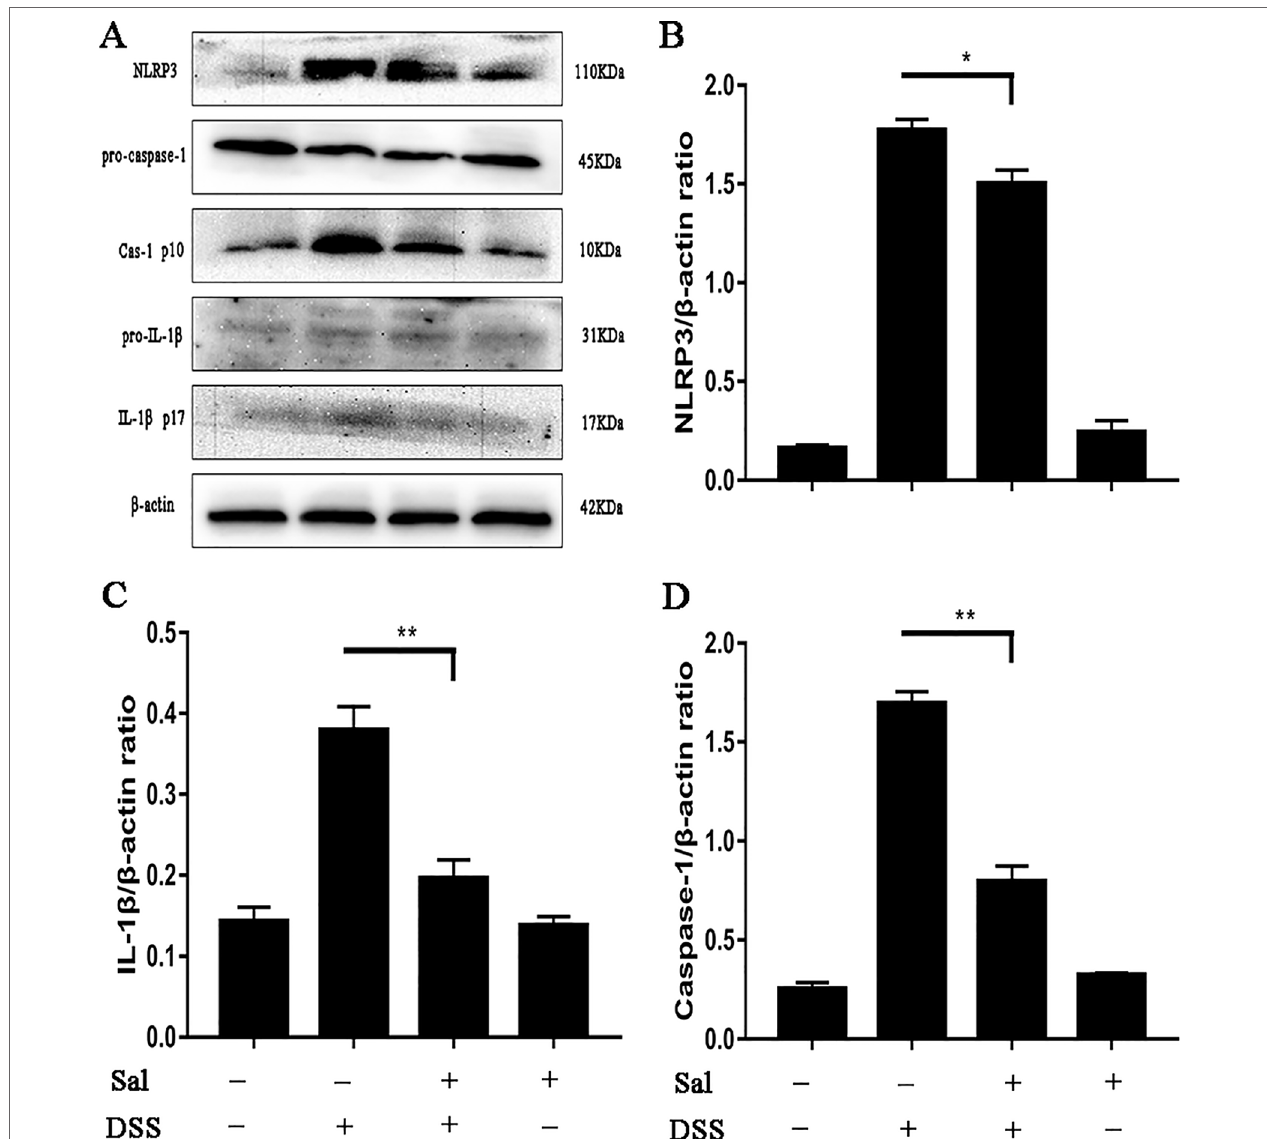
FIgURe 4 | Salidroside suppressed nucleotide oligomerization domain-like receptor family pyrin domain containing 3 (NLRP3) inflammasome activation in dextran sulfate sodium-treated mice. (A) Protein levels of NLRP3, caspase-1, and IL-1β in the colonic tissue were analyzed by western blot. (B, C, D) The relative protein expression of NLRP3, caspase-1, and IL-1β were normalized to β-actin. Data were repeated in three independent experiments. (*) p < 0.05, (**) p < 0.01.